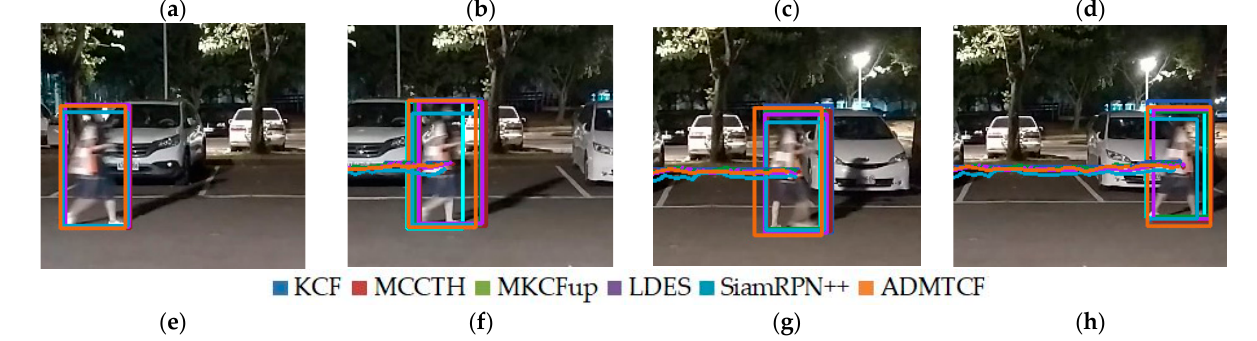
Figure 11. The experimental results of the scenario 3 video with motion blur: ( a ) the 1st frame of the video; ( b ) the 15th frame of the video; ( c ) the 31st frame of the video; ( d ) the 46th frame of the video; ( e ) the cropped and enlarged image of image ( a ); ( f ) the cropped and enlarged image of image ( b ); ( g ) the cropped and enlarged image of image ( c ); ( h ) the cropped and enlarged image of image ( d ).